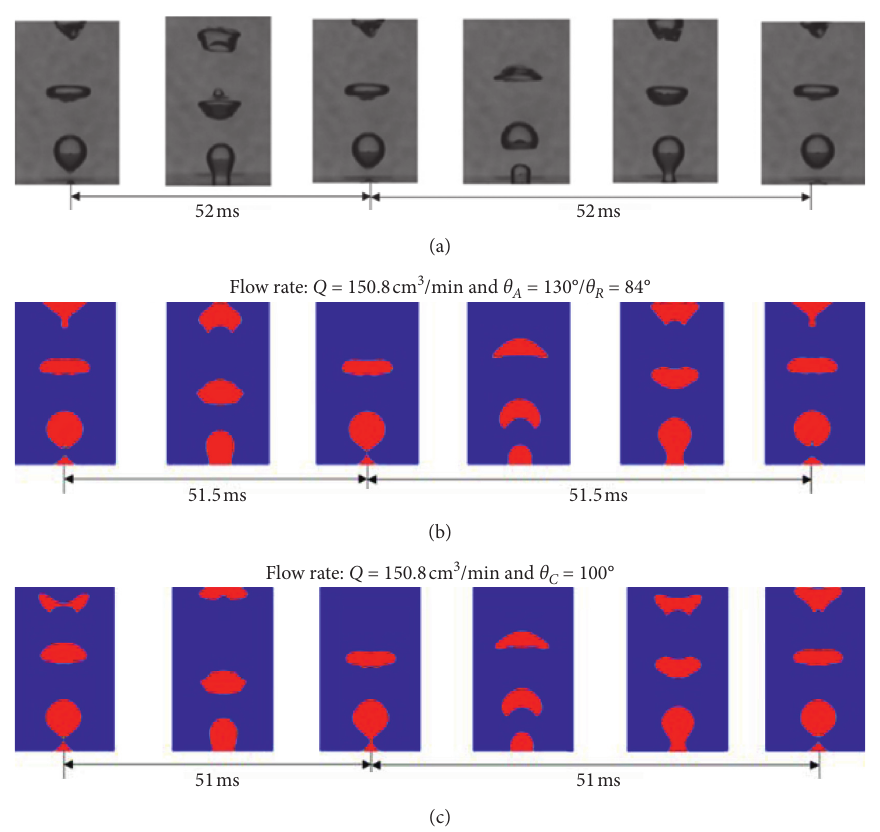
Figure 4: Snapshot comparison of bubble formation ( Q � 150.8 cm 3 /min, Re � 54.77, and d (b) results of dynamic contact angle model simulation ( θ A � 130 ° and θ R � 84 ° ); (c) results of static contact angle model simulation ( θ C � 100 ° ).